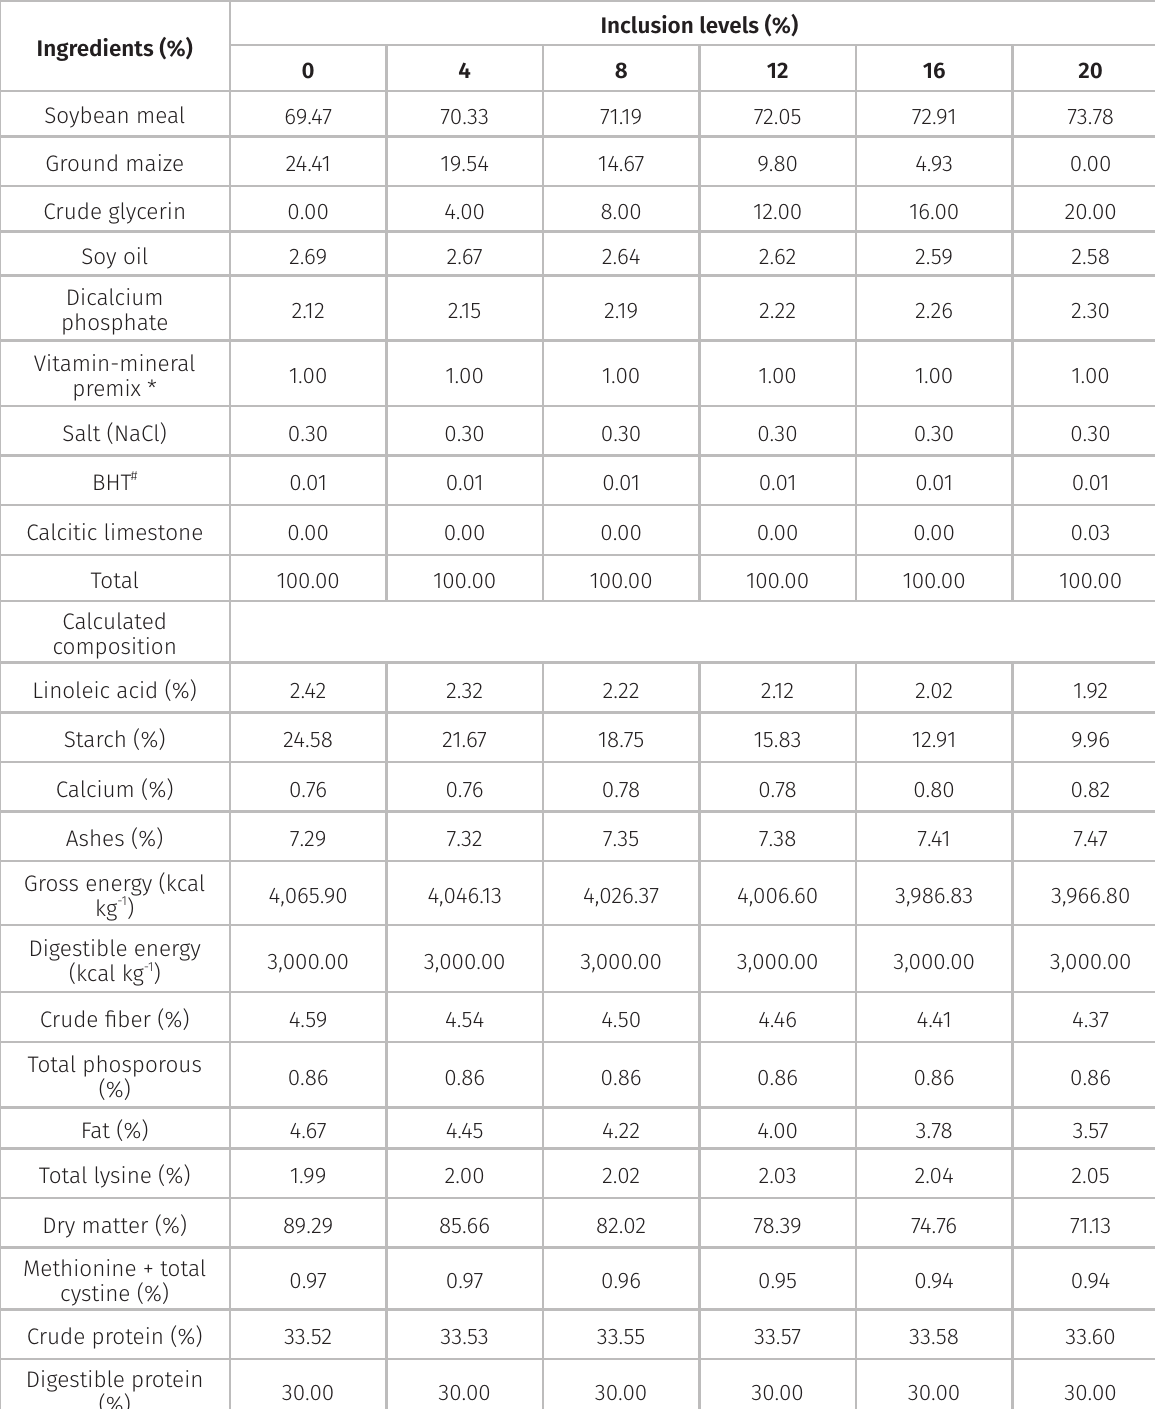
Table I. Formulation and proximate composition of the experimental diets for Nile tilapia fingerlings.